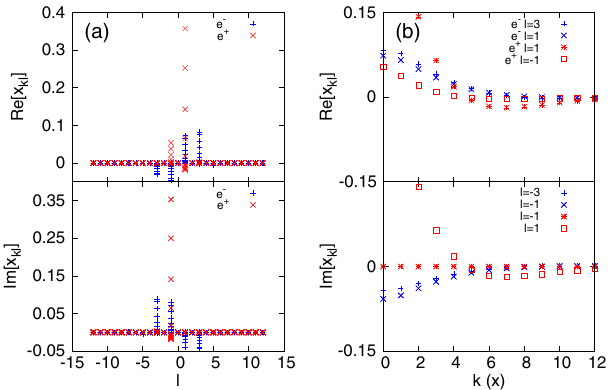
FIG. 21. Eigenvector of unstable mode with the fastest growth ðþÞ ¼ 0 . 53 and ν ð − Þ ¼ 0 . 57 at SuperKEKB. (a),(b) rate for ν x x Eigenvectors as functions of l and k ,